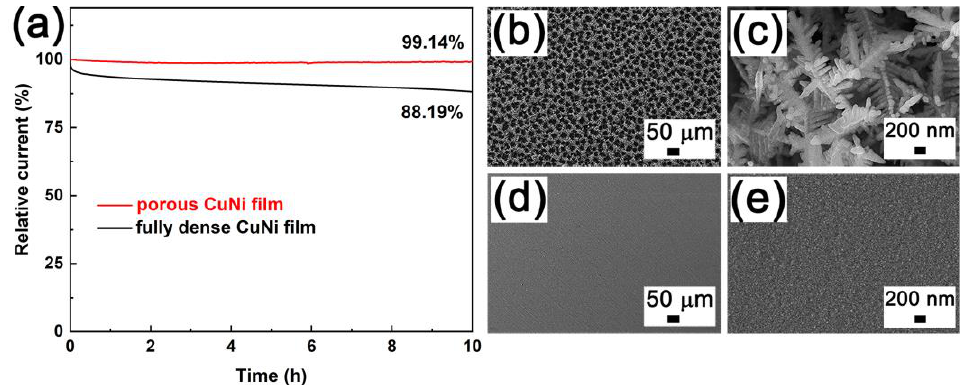
Figure 11. Chronopotentiometry response of porous CuNi film and fully dense CuNi film ( a ). SEM images of porous ( b,c ) and fully dense ( d,e ) CuNi films after 10 h durability tests.